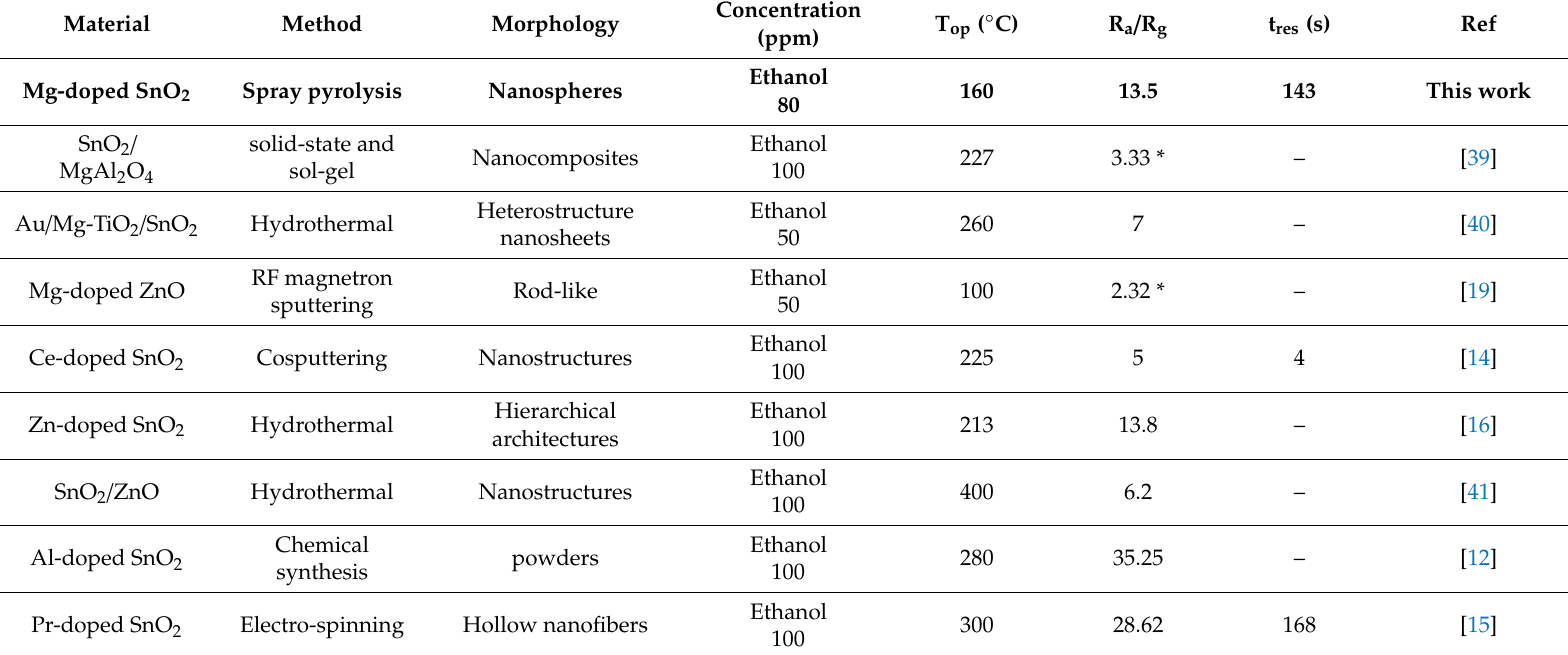
Table 2. Summary of the materials, testing conditions and responses to ethanol and toluene reported in the literature and in our work for